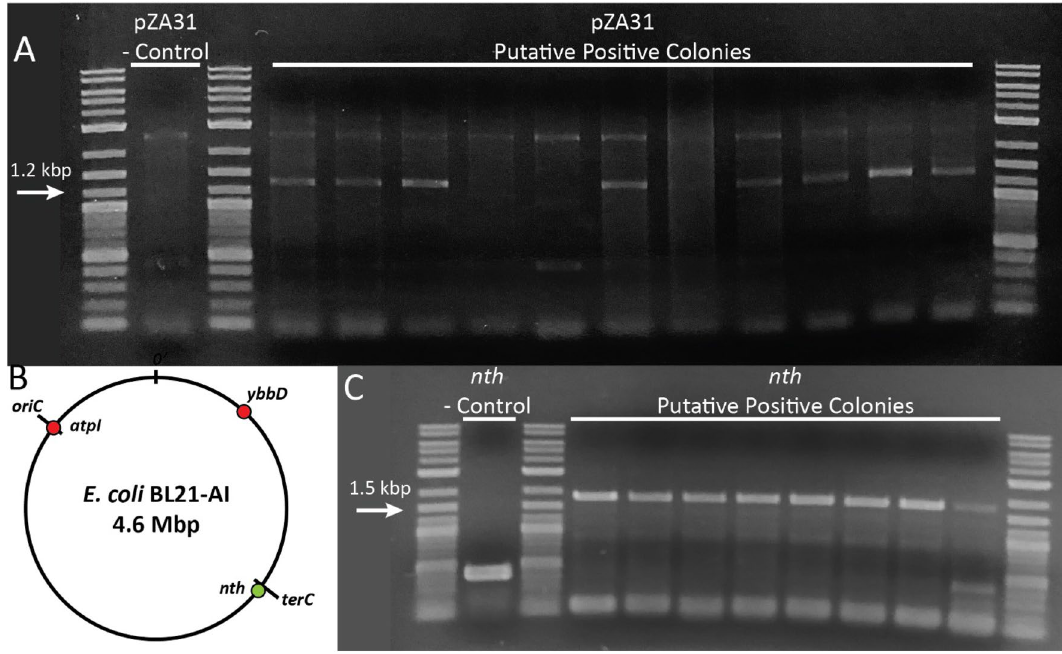
Figure 3. GENEWRITE site-specific insertion in a low-copy number targets. ( A ) Insertion in low copy number (15–30 copies /cell) plasmid pZA31. Chosen primers bind at start of payload promoter and within the adjacent pZA31 sequence after 3’ end of payload. Colony PCR was performed with 10% DMSO to eliminate extraneous non-specific amplification. Expected amplicon is ~ 1300 bp. ( B ) Attempted chromosomal insertion sites. Coordinates of sites are x chromosome = 0.0098 ( atpI ), 0.5476 ( ybbD ), and -0.943 ( nth ), where x = 0 corresponds to oriC and x = ± 1 corresponds to terC . ( C ) PCR amplification across nth integration location. Primers bind to chromosomal regions adjacent to targeted integration site. Amplicon expected from successful integration is ~ 1600 bp. We conservatively identify the last colony as negative for